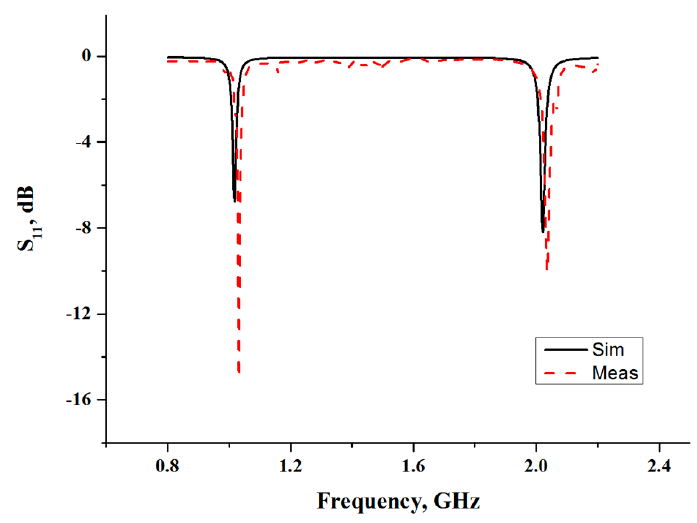
Figure 3. Simulated and measured resonance frequency response of a microwave ring-resonator sensor (without sample).